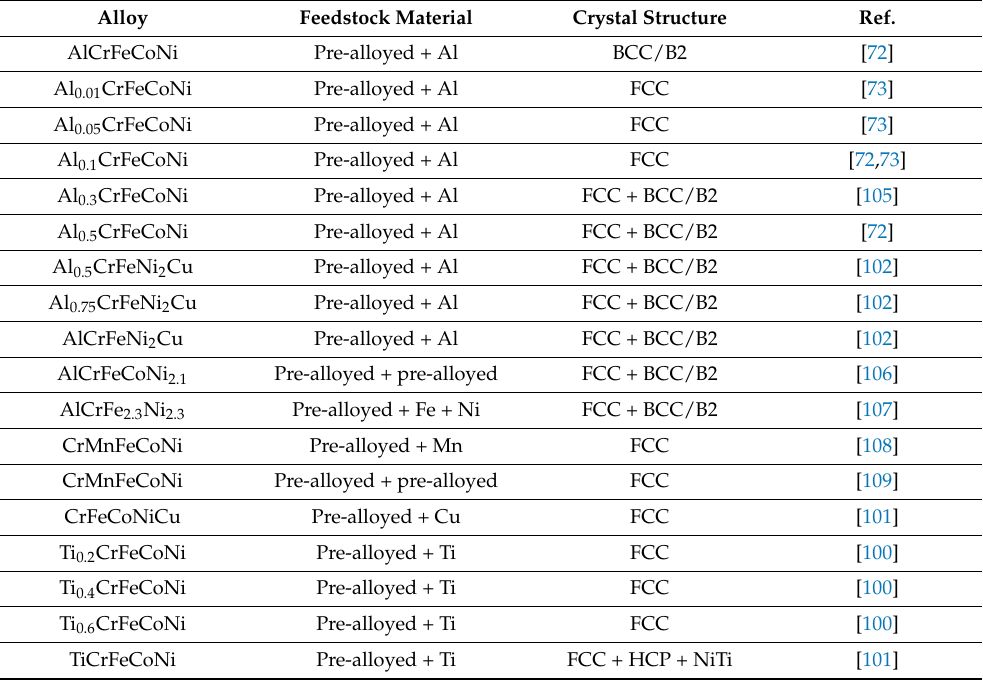
Table 2. LPBF production of HEAs using a blend of pre-alloyed and pure element powders as feedstock